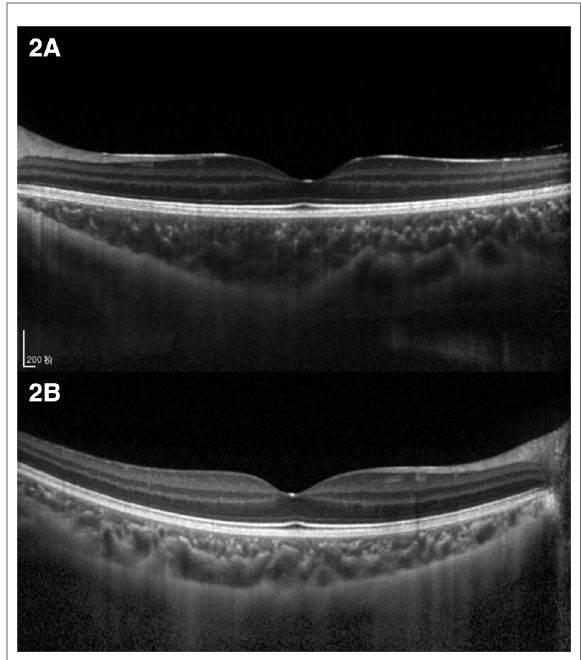
FIGURE 2 Comparison of choroidal structure of macula in a patient with anisometropia amblyopia. ( A ) Choroidal thickness of the hyperopic anisometropic amblyopia eye. ( B ) Choroidal thickness of the fellow